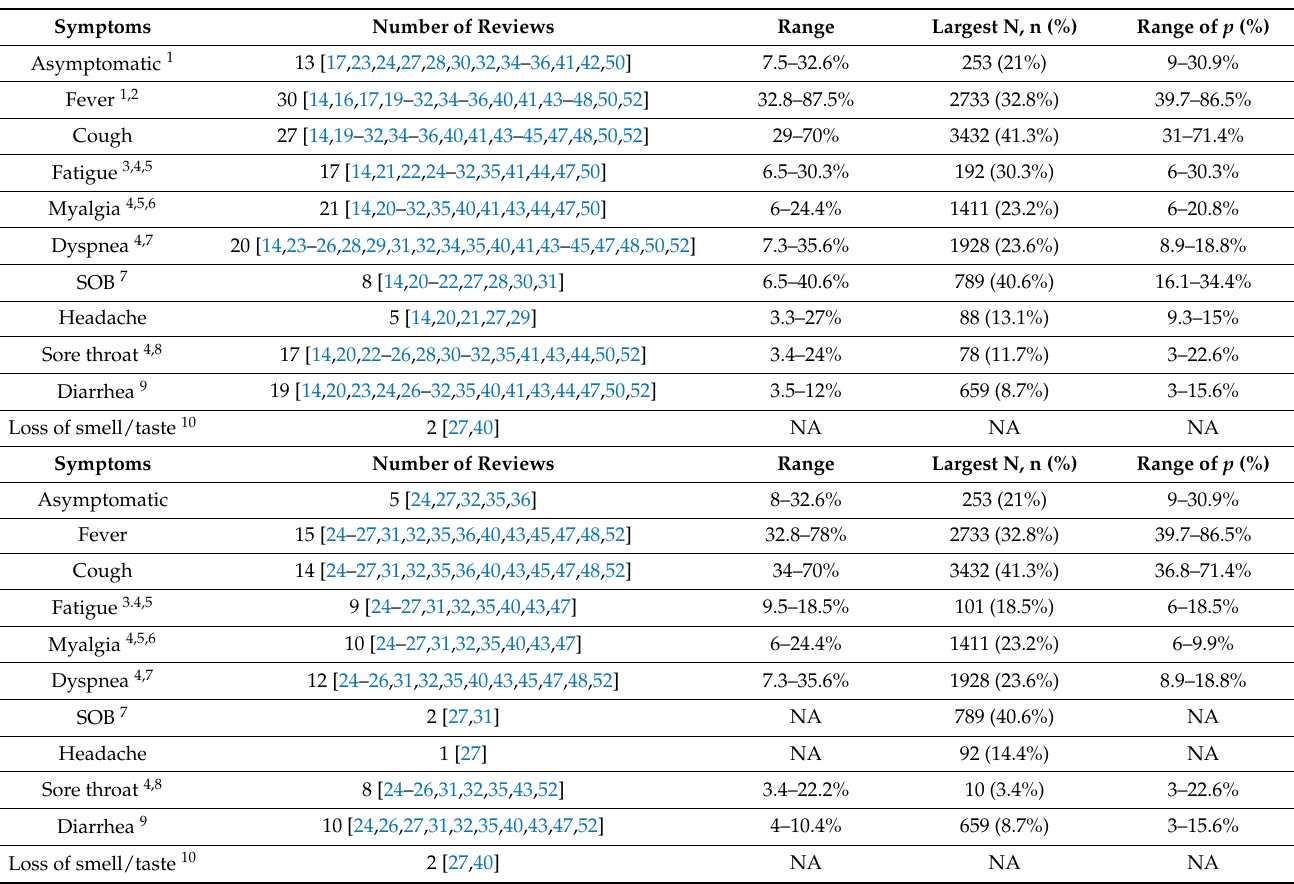
Table 2. Symptoms of infected mothers. Columns demonstrate analyzed outcomes, number of reviews that provided relevant data on the outcome, range of extractable raw rates, the extracted rate from the largest sample analyzed for the outcome and range of extracted pooled rates. Results are extracted from all eligible systematic reviews. Results are extracted only from moderate and high-quality reviews. Bold denotes differences between the two